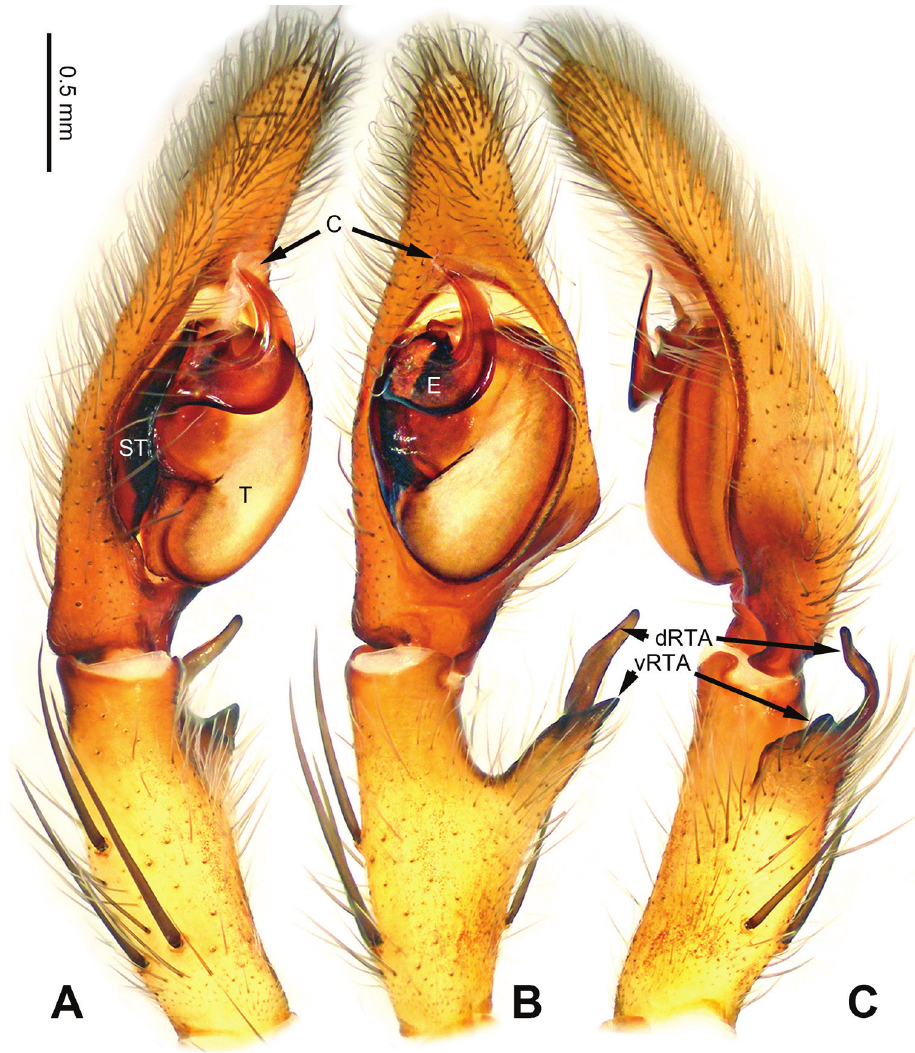
Figure 18. Pseudopoda putaoensis Zhao & Li, sp. n., left palp of male holotype. A Prolateral view B Ventral view C Retrolateral view. Scale bar equal for A, B, C